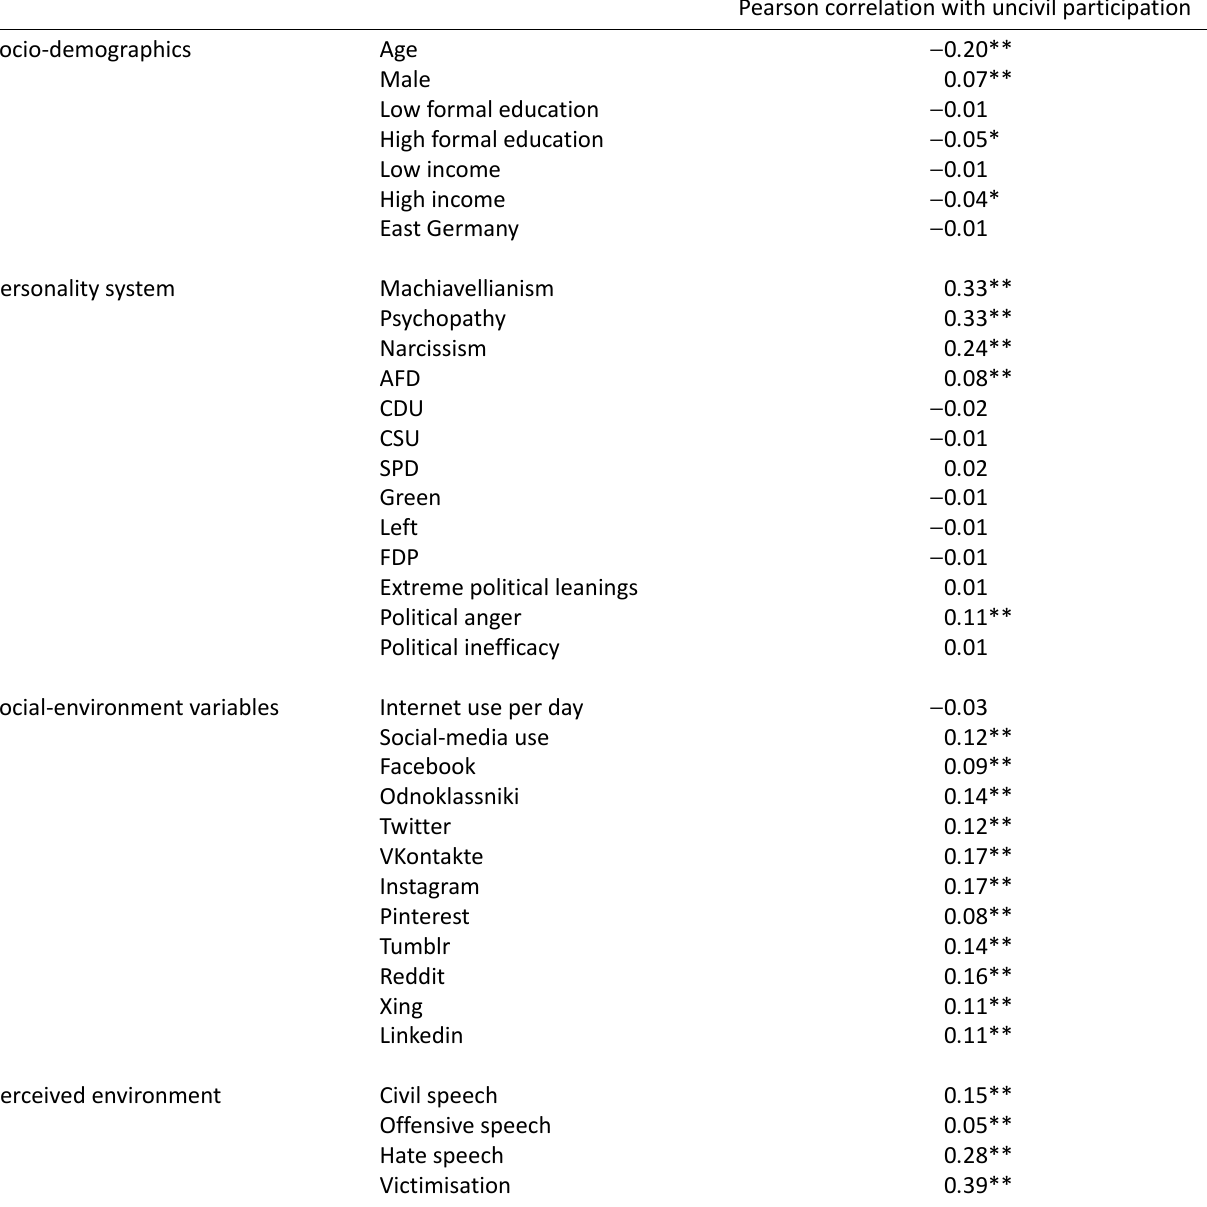
Pearson correlation with uncivil